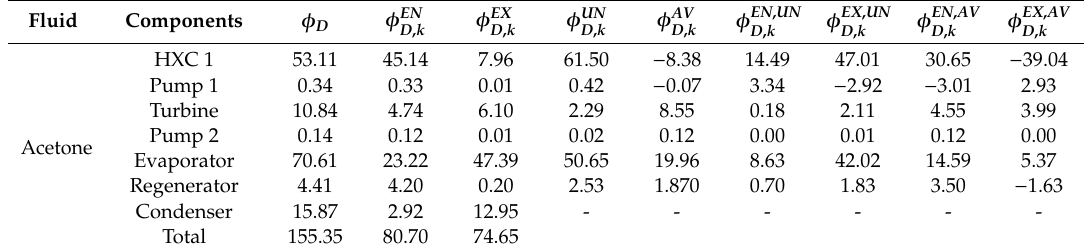
Table 8. Disaggregation of exergy for system components using acetone as working